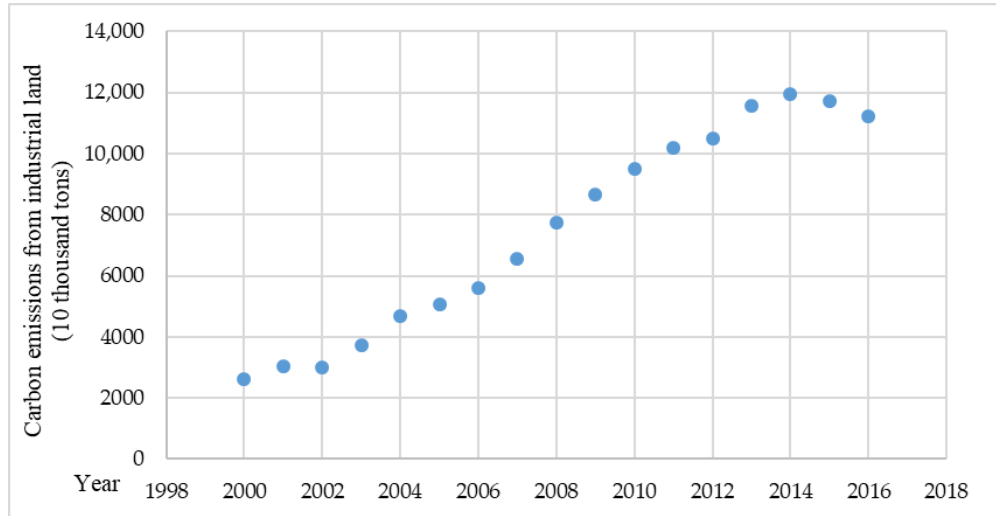
Figure 2. Changes in CEIL, GIOV, and ICEI in Anhui Province from 2000 to 2016.